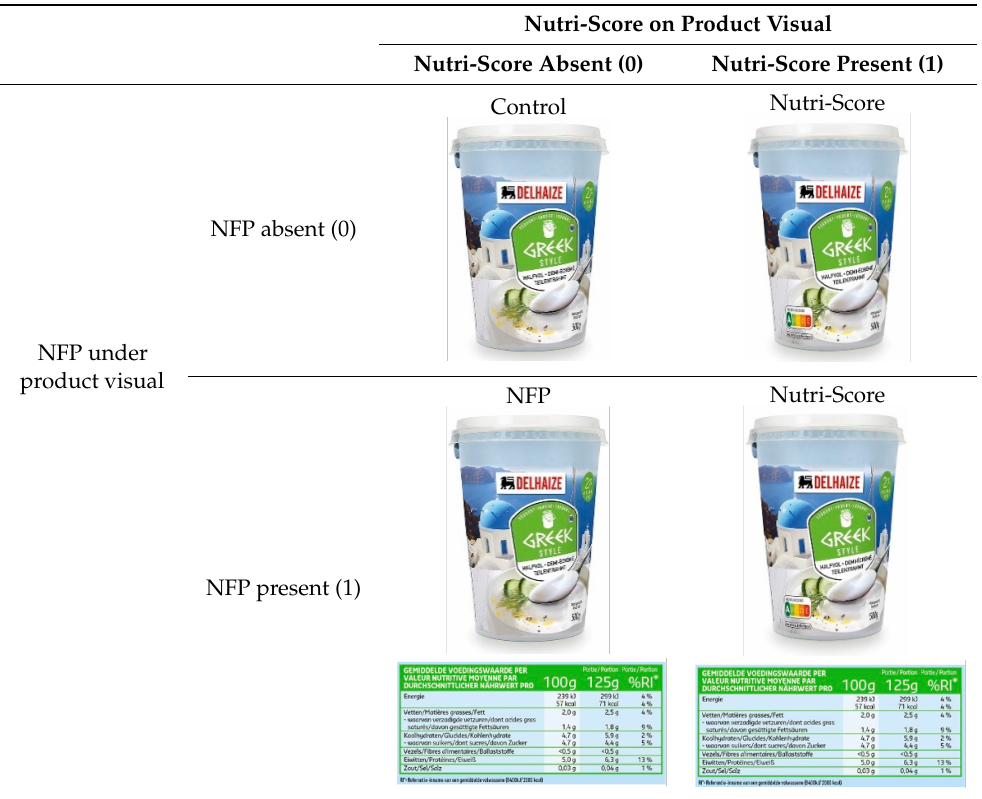
Table 1. Experimental design, with an